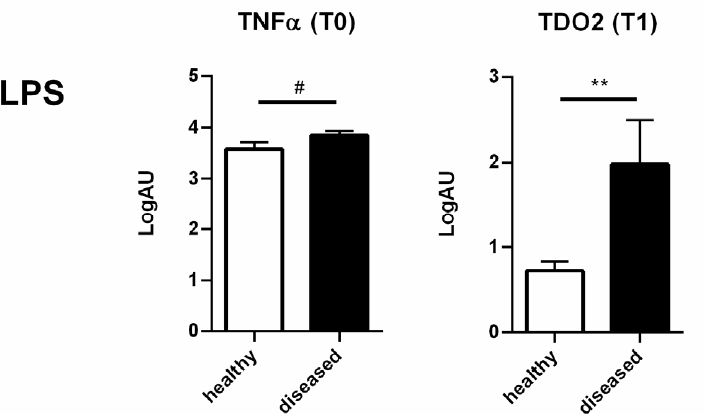
Figure 4. Different responses of PBMCs of healthy and diseased cows. PBMCs of diseased (black bars) and healthy (white bars) cows expressed different levels of proinflammatory cytokines and kynurenin pathway genes under basal conditions and after LPS stimulation at different time points (T0 = 15 days before calving; T1 = 7 days post-calving, T2 = 21 days post-calving). Only the graphs of cytokine expression with p < 0.1 or p < 0.05 are reported. Values are medians, Q1 and Q3. Gene expression was analyzed by RT qPCR. # p < 0.1, * p < 0.05, ** p < 0.01.